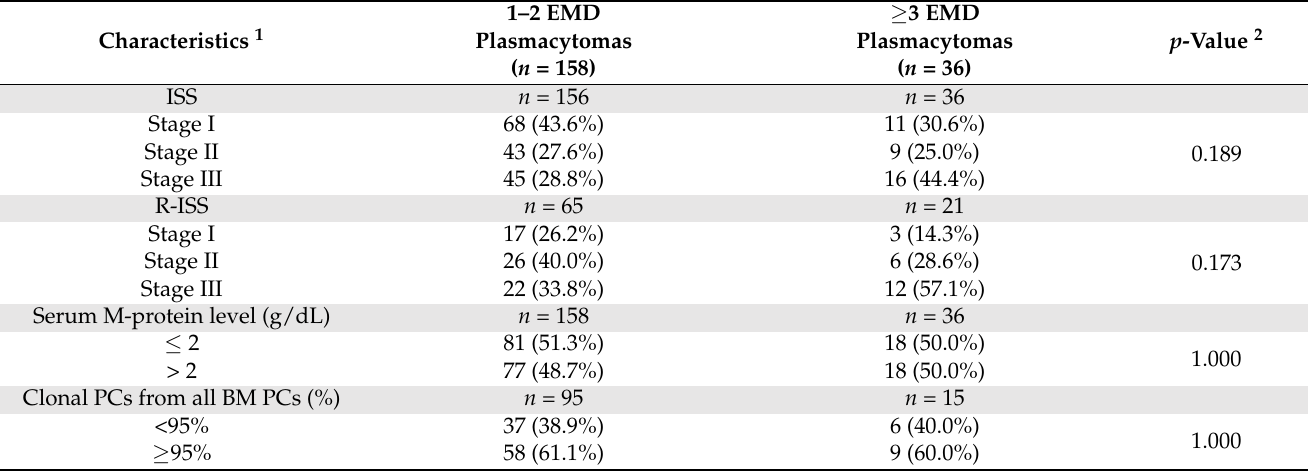
Table 4. Descriptive characteristics according to plasmacytoma count in NDMM patients with EMD